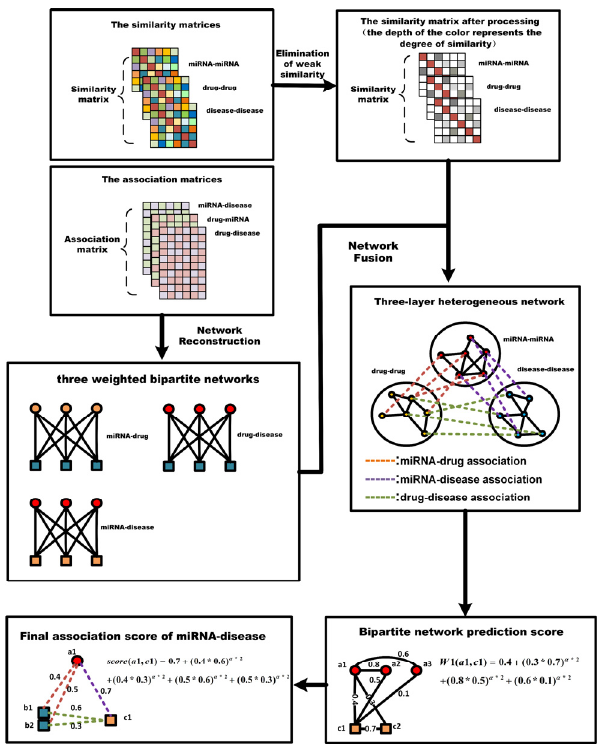
Figure 5. Flowchart of TLNPMD.